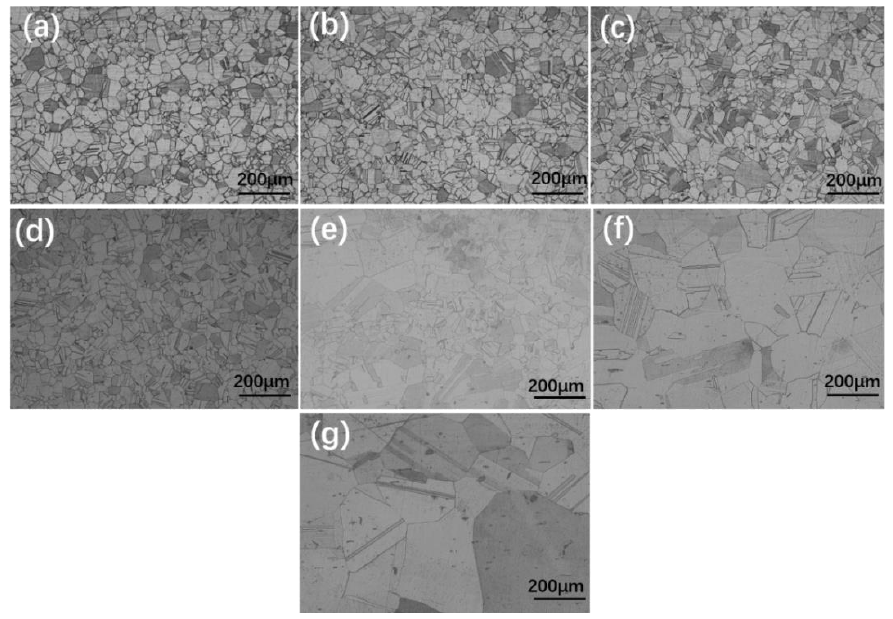
Figure 4. OM of the GH3625 superalloy at different temperatures for 5 min: ( a ) 950 °C; ( b ) 1000 °C; ( c ) 1050 °C; ( d ) 1100 °C; ( e ) 1150 °C; ( f ) 1200 °C; ( g ) 1250 °C.